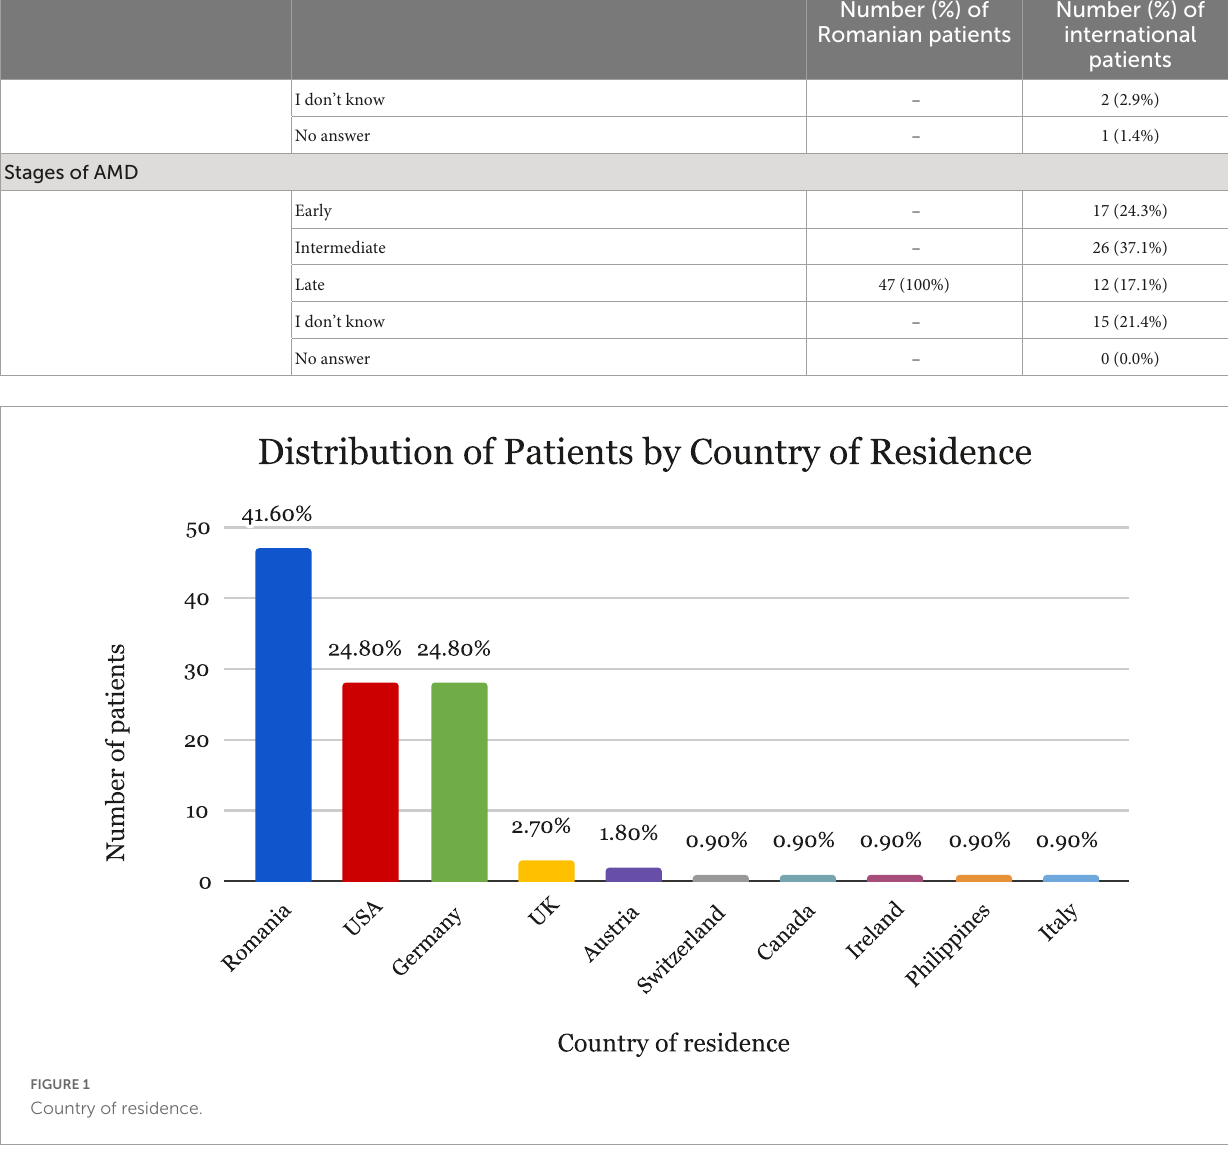
with 70 patients. The country distribution of the participants is presented in Figure 1